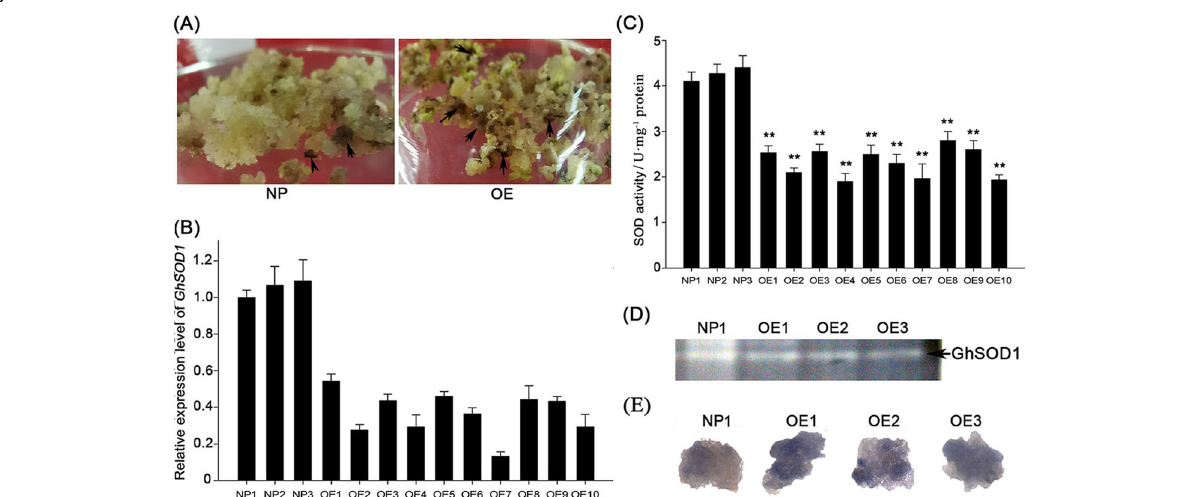
Fig. 2 OsLOL1 overexpression represses GhSOD1 expression and activity. a Cell death around embryogenic callus or somatic embryos. Arrows point to the dead cell masses. NP: Calli transformed by empty vector, OE: Calli with OsLOL1 overexpression. b Relative expression level of GhSOD1 in embryogenic calli with empty vector or OsLOL1 gene. GhUbi gene was used as internal control for normalization. The expression levels of OE1 and NP1 are arbitrarily regarded as “ 1 ” , respectively. c SOD activity of embryogenic calli with empty vector or OsLOL1 gene. d SOD activity by staining analysis in gel in embryogenic calli with empty vector or OsLOL1 gene. e ROS accumulation of cotton calli by NBT staining analysis. In ( d ) and ( e ), NP1 is a represent of the embryogenic calli with empty vector. OE1 – 3 are representatives of the embryogenic calli with OsLOL1 overexpression. Bar represents SD from three biological repeats in ( b ) and ( c ). An asterisk or double asterisks show significant ( P < 0.05) or extremely significant ( P < 0.01) differences of OEs compared with NP1 by Student ’ s t -test in ( c ) and ( d